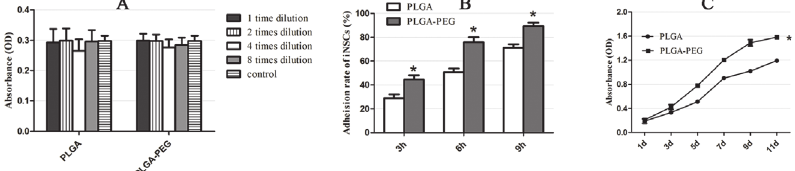
Fig 9. iNSCs survival, adhesion and process extension on electrospun nanofibers. Cell viabilities of iNSCs in both PLGA and PLGA-PEG group were no significant differences than blank (A). Cells adhesion rates on PLGA-PEG scaffolds were significantly higher than those of PLGA scaffolds at each time point (P < 0.05) (B). And for the detection of cell proliferation, the numbers of iNSCs in PLGA-PEG group were significantly higher than that of PLGA group (P < 0.05)